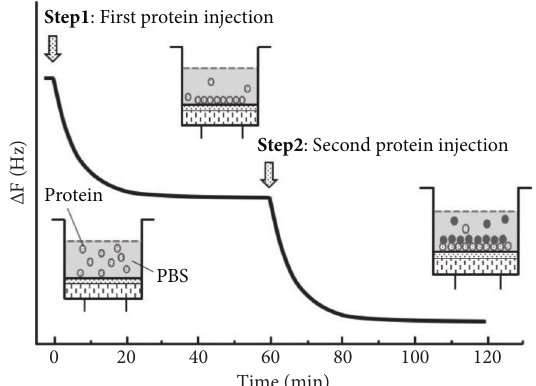
Figure 2: Typical frequency-decrease curve and schematic diagram of the sensor cell for QCM measurement using two-step adsorption methods.